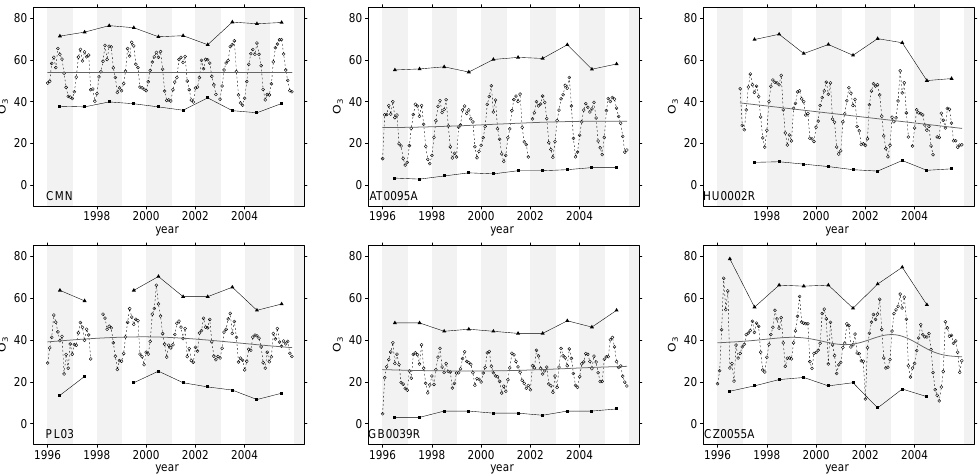
Fig. 4. Examples of categorised loess trends of observed monthly mean O 3 (ppbvyr − 1 ) (all sites available in Fig. A1 of the Supplement) displaying no trend (top left), increasing trend (top middle), decreasing trend (top right), increasing then decreasing trend (bottom left), decreasing then increasing trend (bottom middle right) and a complex trend (bottom right). Circles = monthly mean, squares = annual 5 th percentile, triangle = annual 95 th percentile, grey line = loess trend of monthly mean